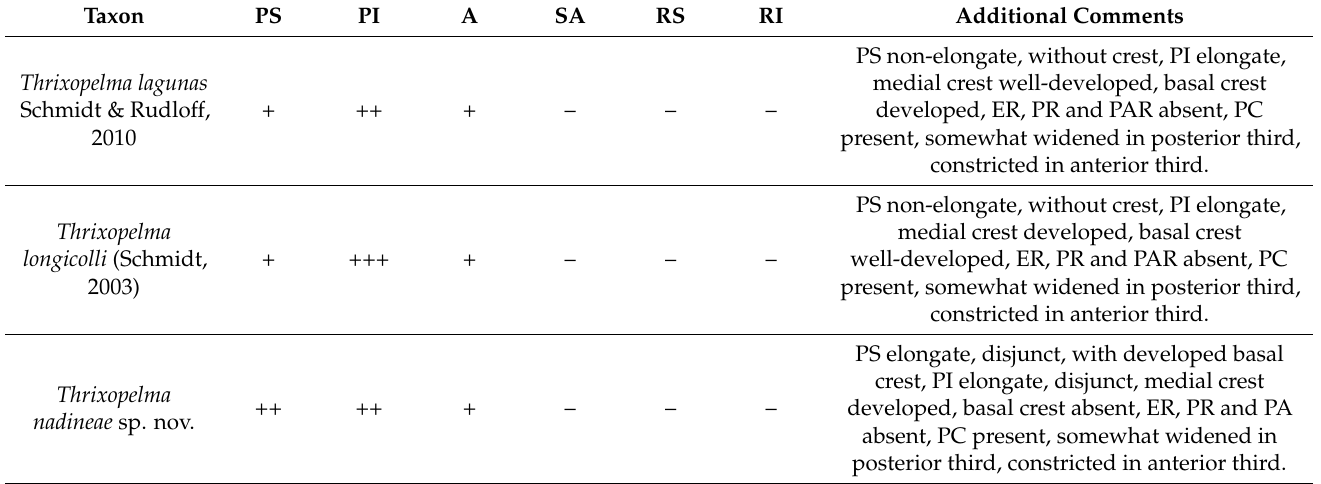
Table 2. Bulb keel morphology of Thrixopelma nadineae sp. nov. and other species of Thrixopelma Schmidt, 1994, sensu Sherwood et al. [2] where males are properly known. Format follows Bertani [7] and Gabriel [8] with modifications based on the new palpal bulb features detailed by Gabriel & Sherwood [9]. Homologous keels present: weakly developed (+), developed (++), well-developed (+++), or absent